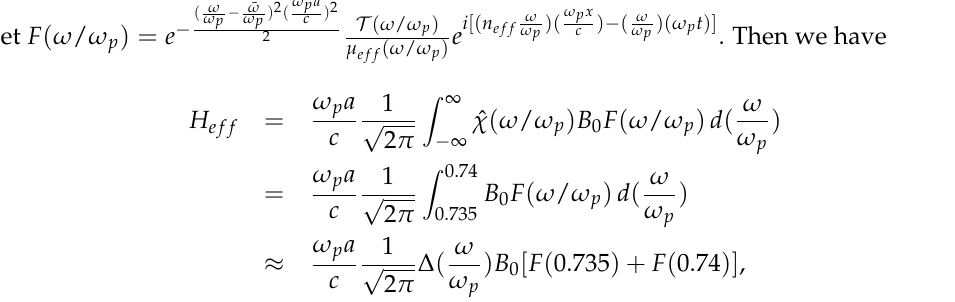
Figure 8. H field in vacuum with interaction between incident and reflective waves for ω p t = 5.